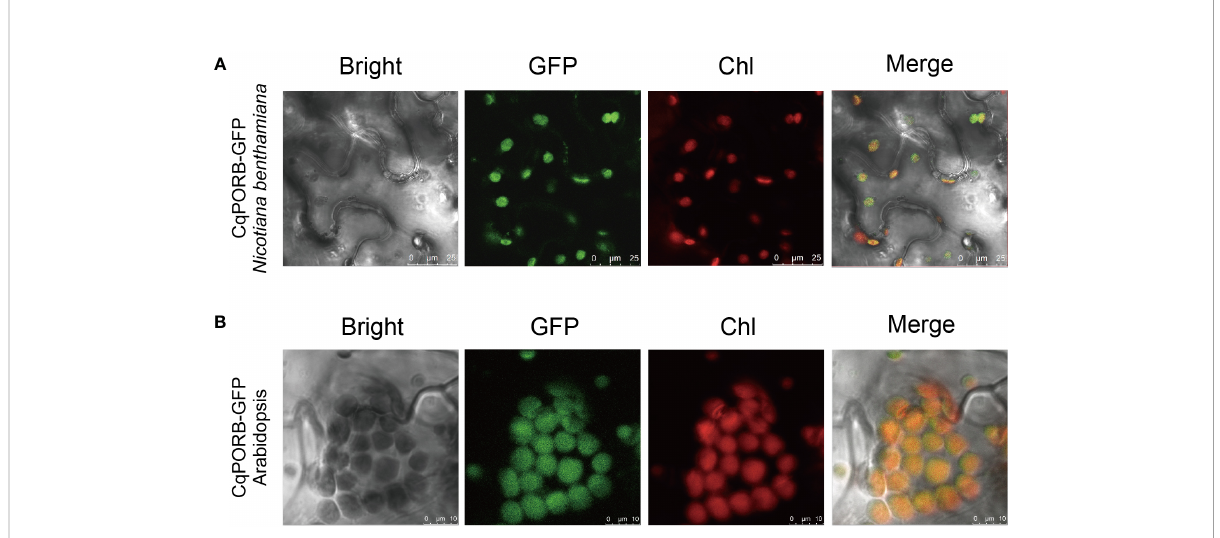
FIGURE 6 Analysis of the subcellular localization of CqPORB. (A) CqPORB-GFP was transiently expressed in Nicotiana benthamiana , and fl uorescence was detected using confocal laser scanning microscopy. Scale bar, 25 µm. (B) The subcellular localization of CqPORB was analyzed in Arabidopsis transgenic plants expressing CqPORB-GFP. Fluorescence was detected using confocal laser scanning microscopy. Scale bar, 10